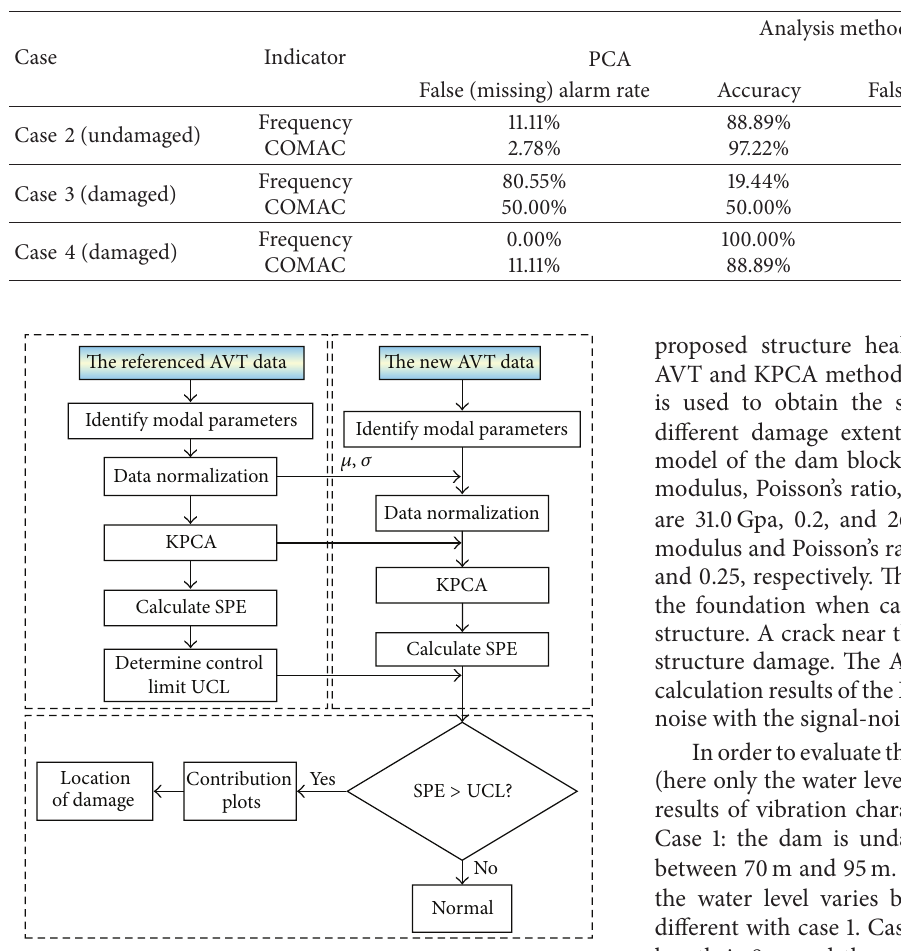
Figure 3: The dam health monitoring method based on AVT and